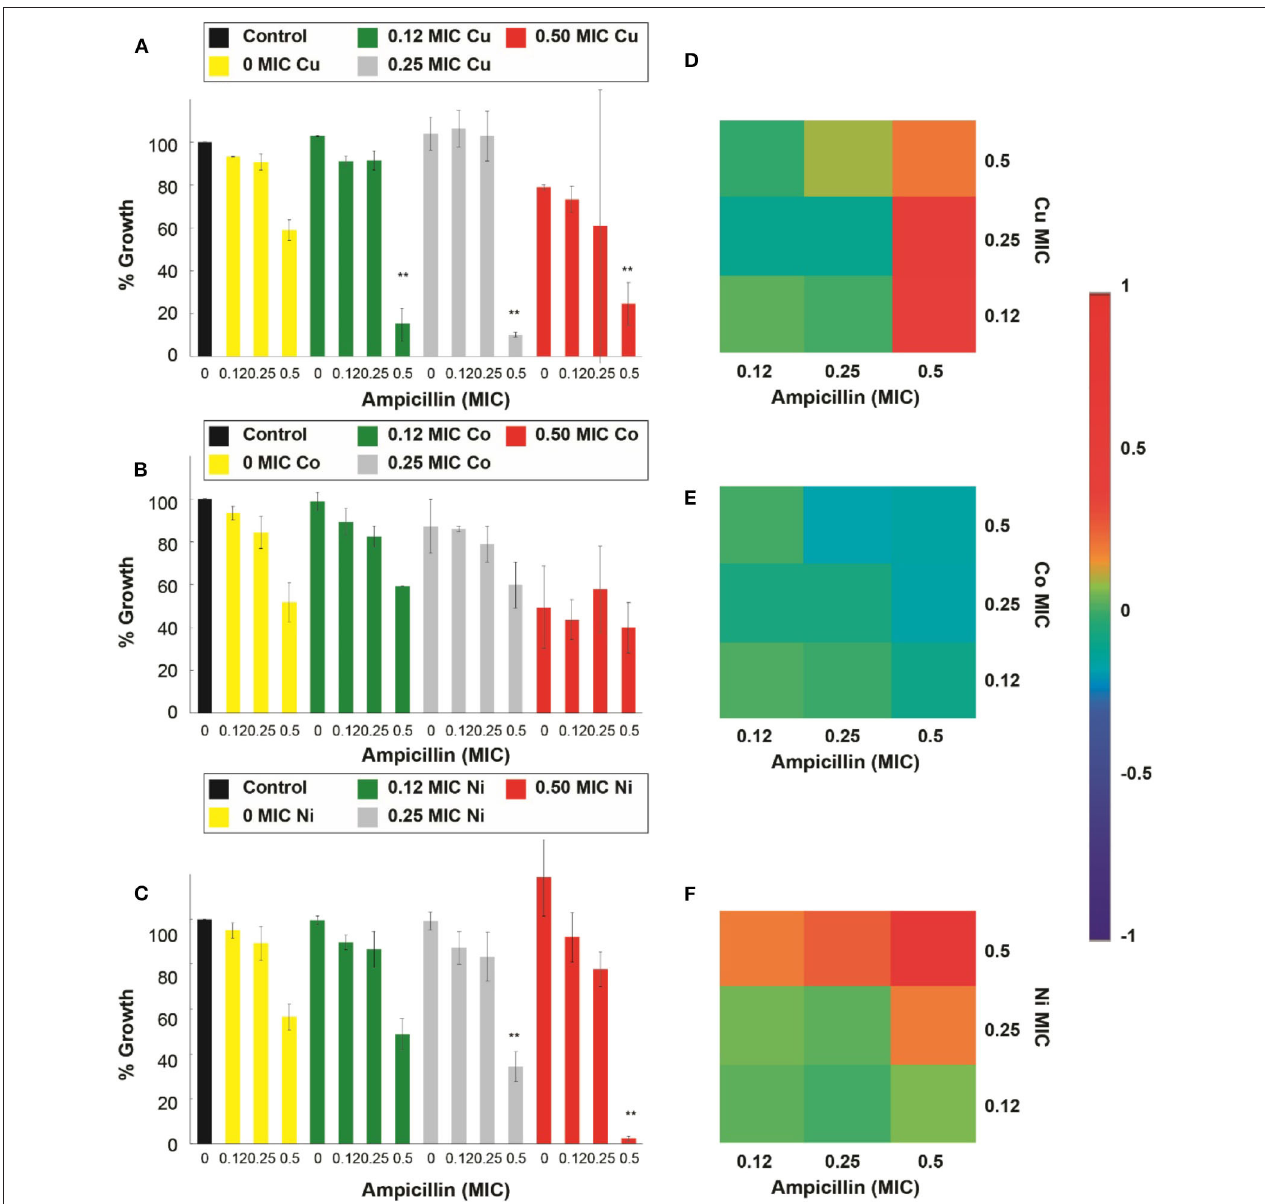
FIGURE 6 | Antimicrobial effect and interactions of ATMCs in ampicillin-resistant E. coli . Growth percentage by sub-inhibitory concentrations of metal ion-antibiotic combinations: (A) Cu 2 + -ampicillin, (B) Co 2 + -ampicillin, and (C) Ni 2 + -ampicillin against E. coli-Amp . Classification of the different interactions between metal ion-antibiotic combinations. The interactions of (D) Cu 2 + -ampicillin, (E) Co 2 + -ampicillin, and (F) Ni 2 + -ampicillin combinations are classified as synergistic, additive or antagonist, value > 0, = 0 and, < 0, respectively. Each experiment was done in triplicates. **Corresponds to a significant difference ( p < 0.05) concerning the control and each of the individual treatments. Error bars correspond to the standard deviation from experiments performed in